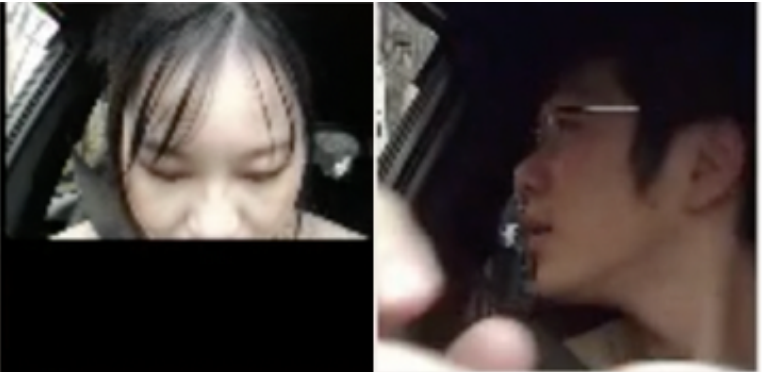
Figure 9. Examples of situations when misclassification may happen for 2D